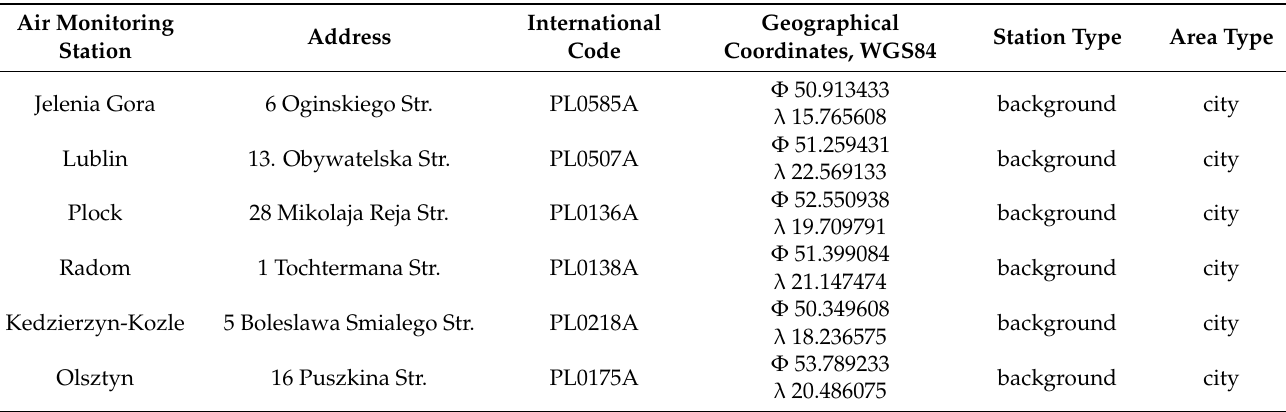
Figure 1. Location of the chosen automatic air monitoring stations in Poland. Table 1. Basic information about the air monitoring stations [41].